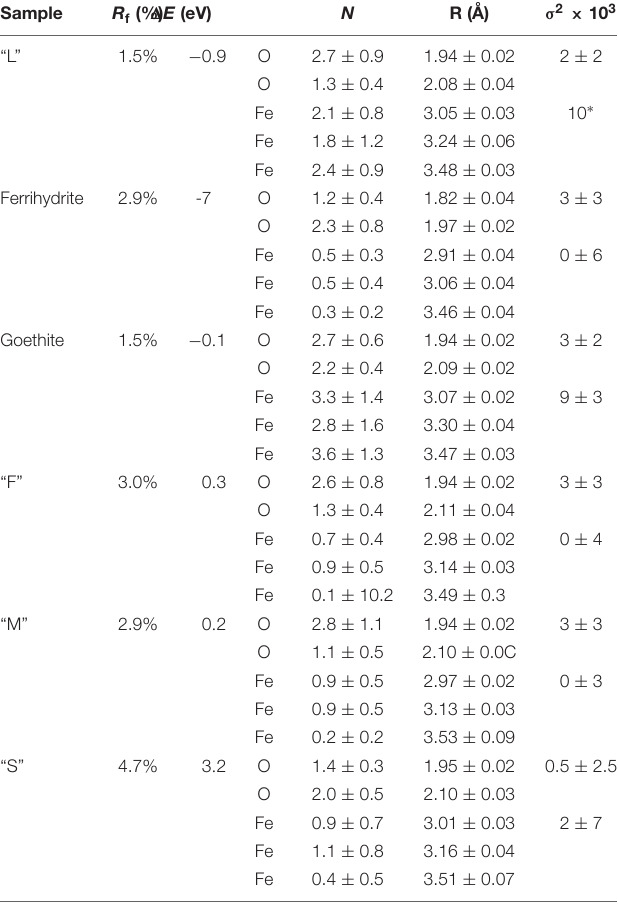
TABLE 2 | The model parameters calculated from the EXAFS spectra for three 57 Fe-NFs samples used in this study.